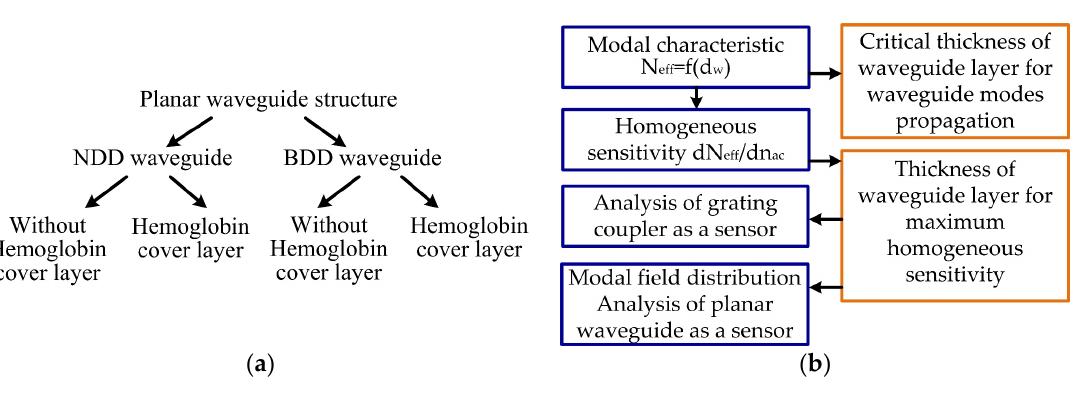
Figure 2. Scheme of the theoretical analysis: ( a ) types of diamond-based planar waveguide structures, ( b ) analysis steps. Table 1. The refractive index for each layer in modeled waveguide structure.